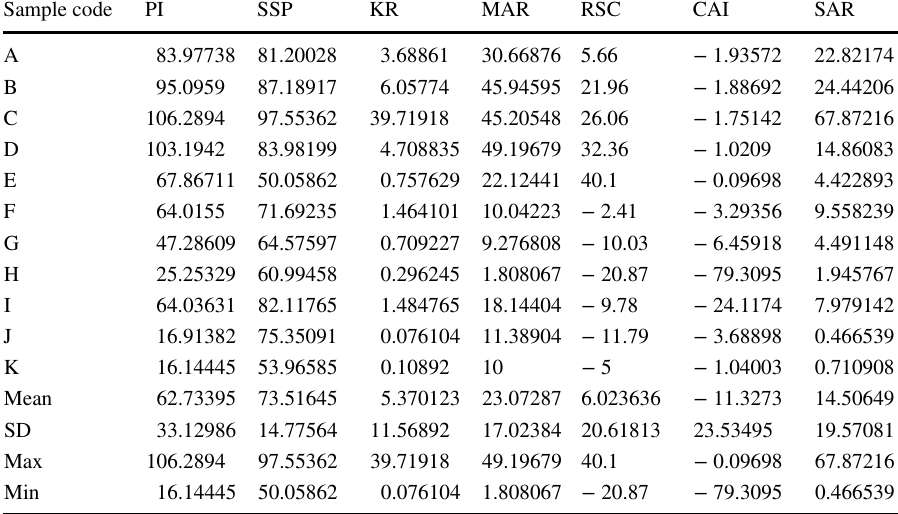
Table 4 Assessment of